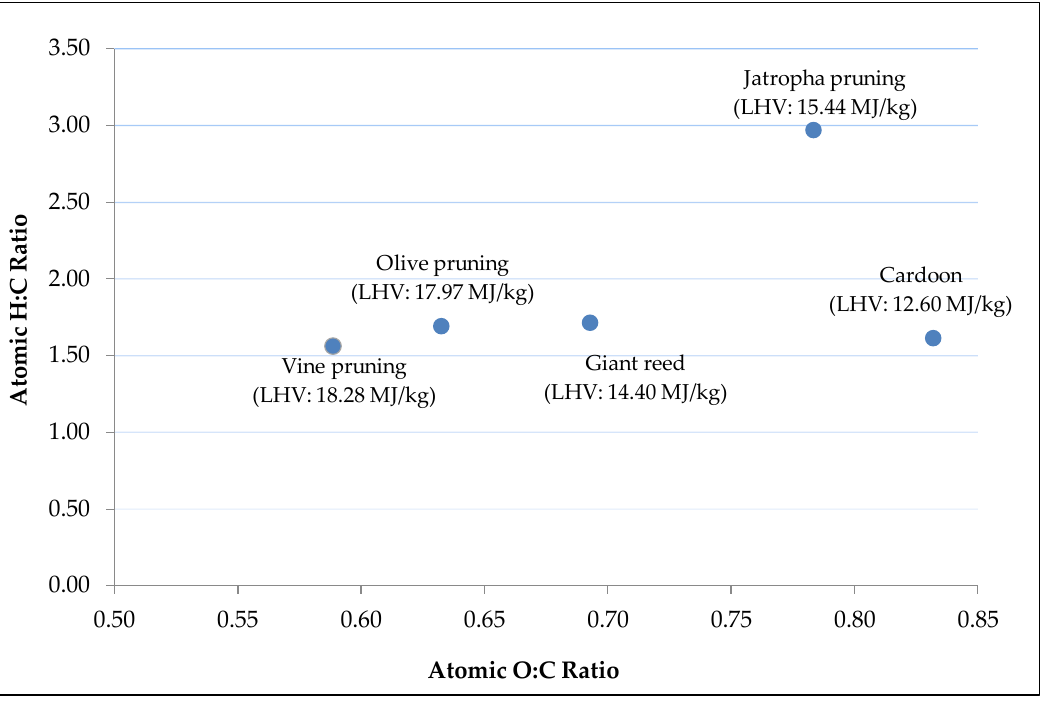
Figure 2. Van Krevelen diagram—hydrogen:carbon (hydrogen index) as a function of the oxygen:carbon (oxygen index) atomic ratios of the biomass analysed.